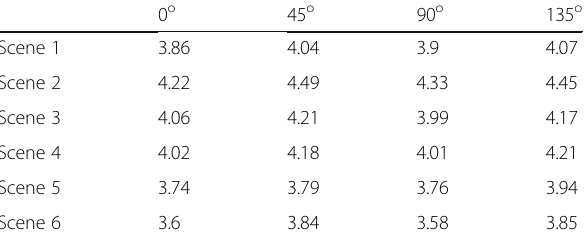
Table 1 Entropy of different scenes in four directions